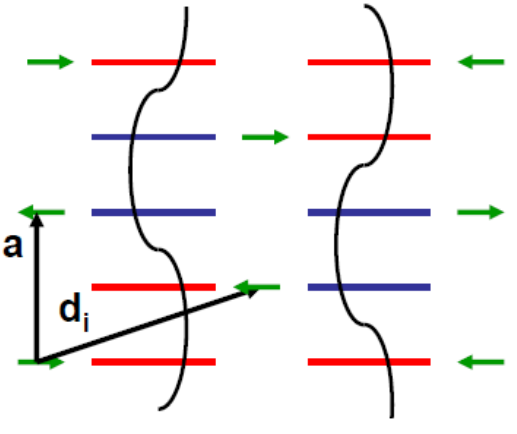
Figure 3 resumes this synchronous CDW – anion shift pattern. Figure 3. Schematic representation in the ( a , d coupled to anion shifts (in green). Donors with an excess (defect) of hole are shown in red